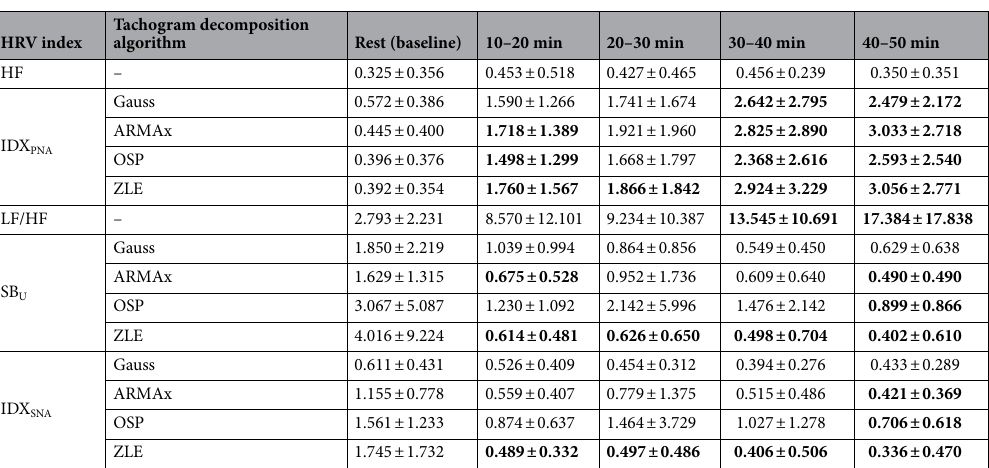
Figure 7. Changes in proposed HRV indices (( a ): IDX PNA and ( b ): IDX SNA ) during mindfulness meditation. Gauss (green boxes and dotted line); ARMAx (blue boxes and dashed line); OSP (yellow boxes and dash-dotted line); ZLE (red boxes and solid line).